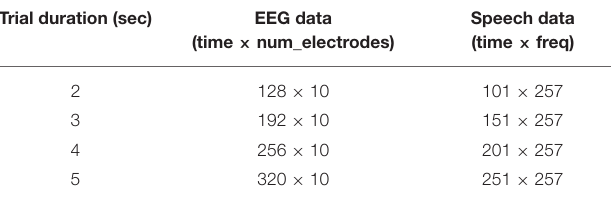
TABLE 2 | Trial duration vs. dimension of the